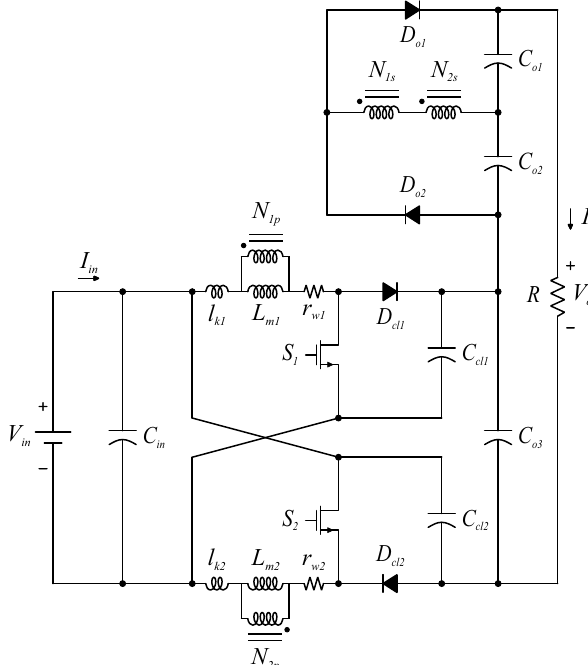
Figure 1. Equivalent circuit of the proposed